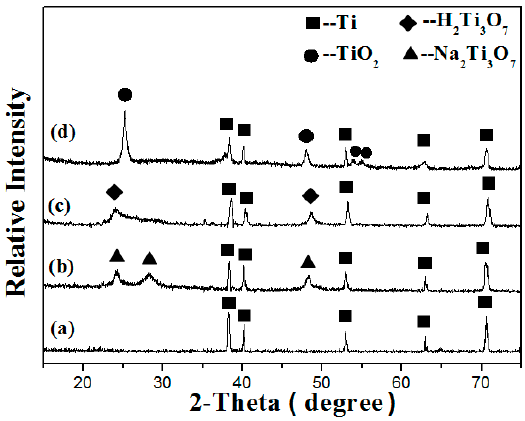
Figure 1. X-ray diffraction (XRD) patterns of samples. (a) Ti foil; (b) intermediate on the Ti foil; (c) intermediate product after pickling is on the Ti foil; (d) TiO 2 nanotubes network.